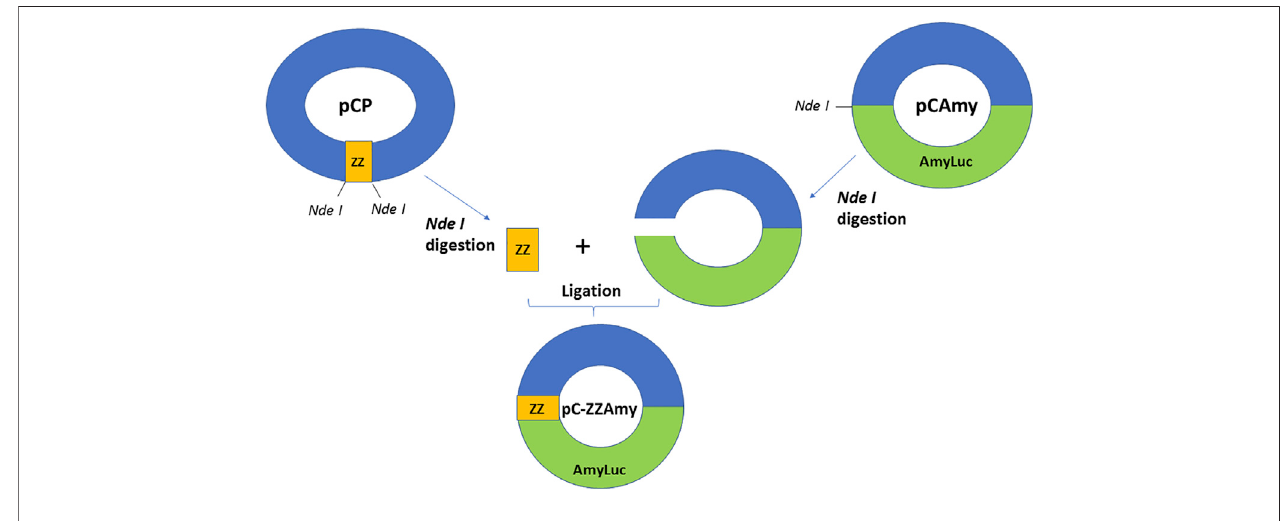
FIGURE 1 | Chimeric ZZ-Amy protein DNA construction scheme.